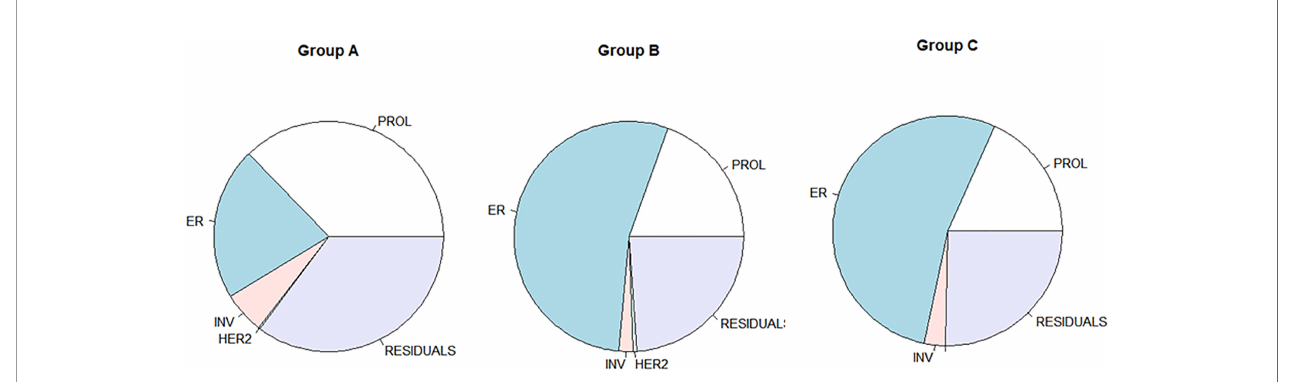
FIGURE 2 | The variance of RS scores as accounted for by individual modules. RS, recurrence score.